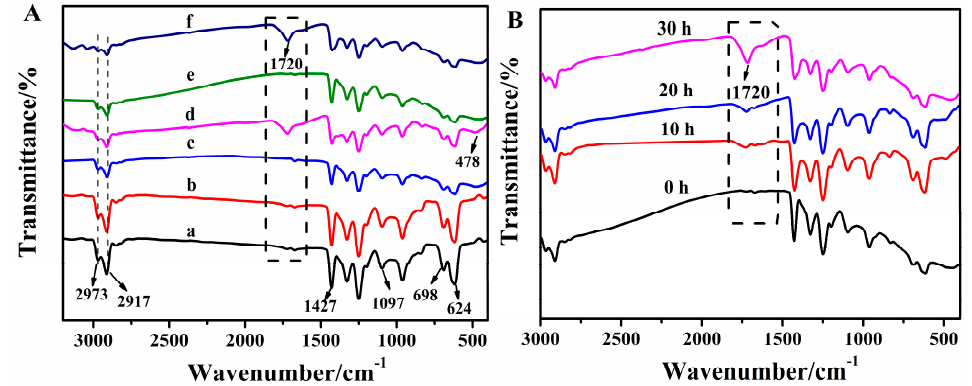
Figure 6. FT-IR spectra of polymer films. ( A ) (a) PVC before irradiation (b) PVC after irradiation, (c) TiO 2 /PVC before irradiation (d) TiO 2 /PVC after irradiation, (e) La 3+ /TiO 2 /PVC before irradiation (f) La 3+ /TiO 2 /PVC after irradiation. ( B ) La 3+ /TiO 2 /PVC after irradiation for 0 h, 10 h, 20 h, 30 h. Table 1. The characteristic peak of infrared spectrum structure.